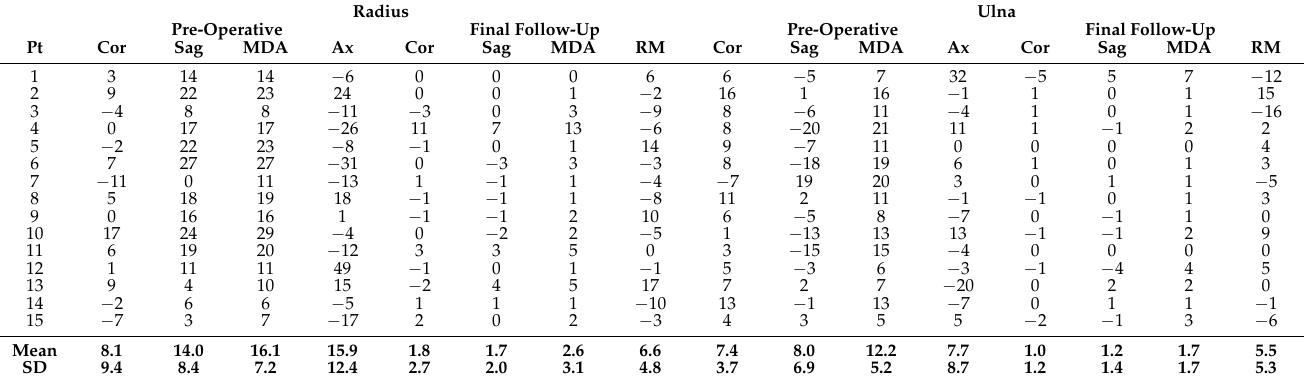
Table 1. Radiographic outcomes: pre- and post-operative malalignment ( ◦ ). Radius